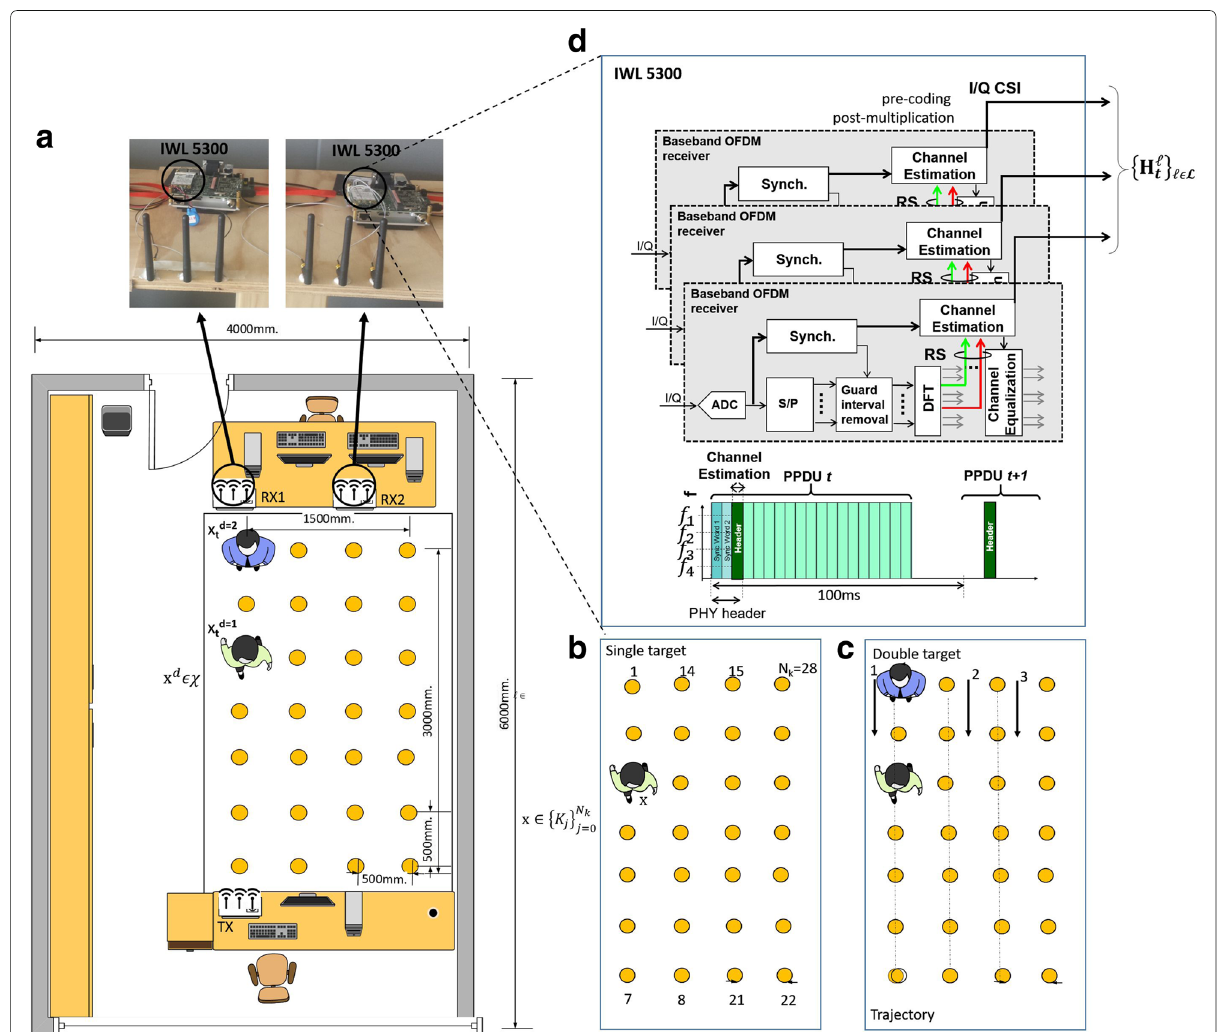
Fig. 4 Experimental layout for single and double target performance evaluation. a Office layout with one transmitter (TX) and two receivers (RX1 and RX2). b Single target d = 1 scenario. c Two targets d = 1,2 (i.e., N d = 2) with sample trajectories. d Simplified baseband model of